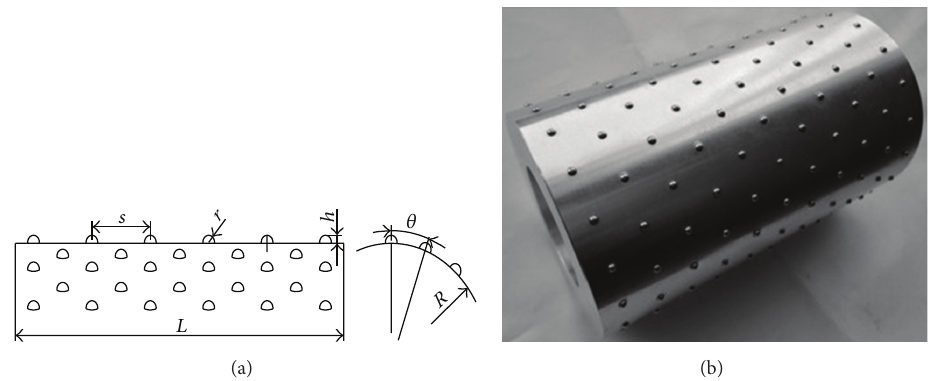
Figure 2: Model of hot-rolling-head: (a) the morphology of rolling-head parameter and (b) the physical hot-rolling-head.